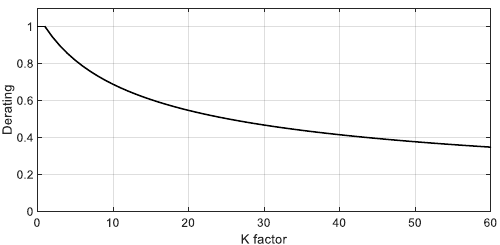
Figure 9. Transformer de-rated capacity depending on the K -factor.